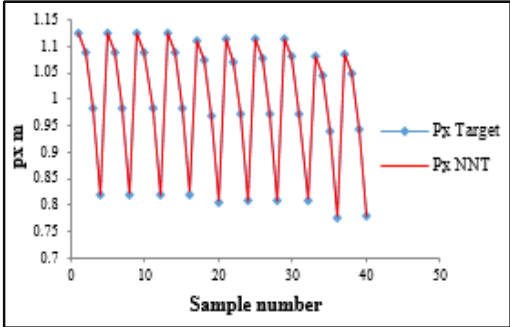
Fig. 17 the comparison between px target and px ONN.